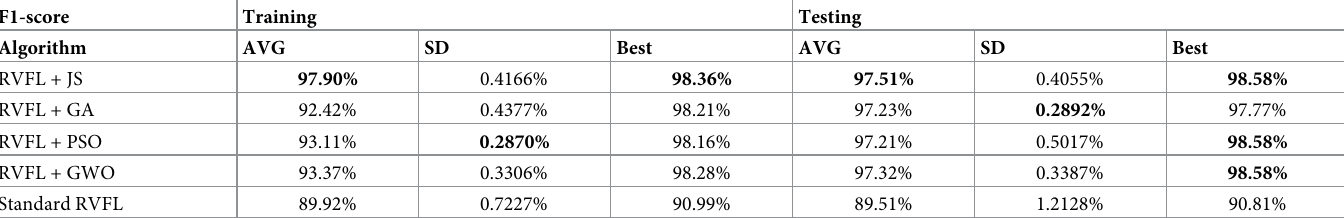
Table 7. Measurement macro F1-score of RVFL+ JS against other metaheuristic algorithms. F1-score